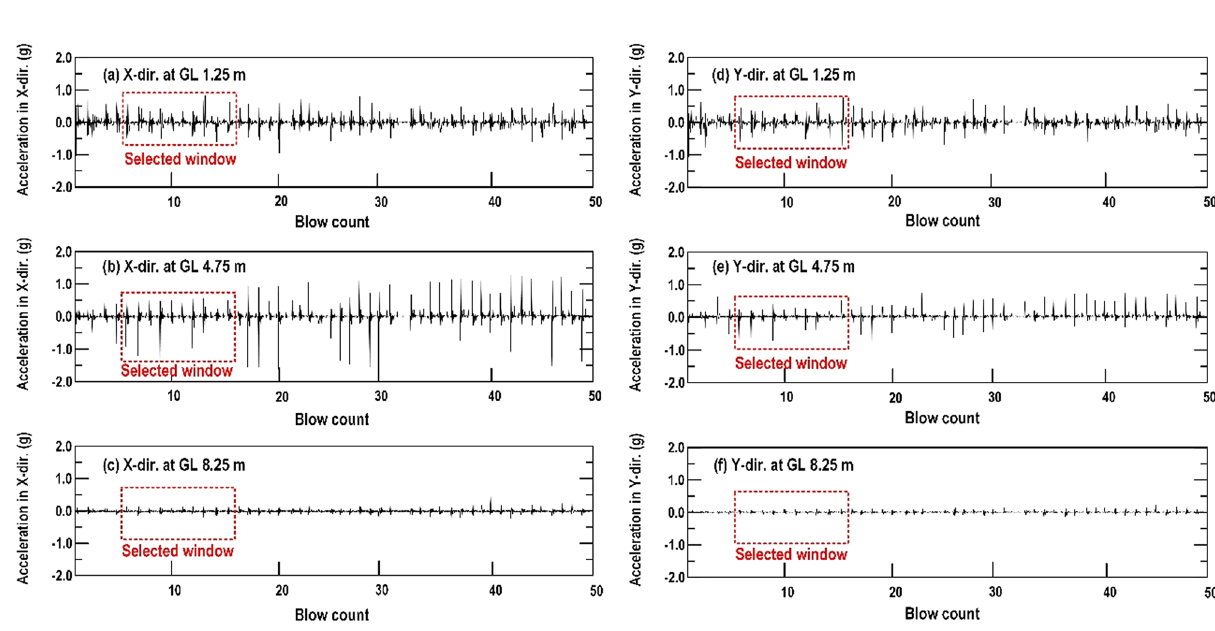
Figure 7. Soil particle acceleration recorded from the vertically installed SAA string during RIC at impact points 1–8: ( a – c ) X-direction response at GL values of 1.25, 4.75, and 8.25 m; ( d – f ) Y-direction response at GL values of 1.25, 4.75, and 8.25 m (GL, ground